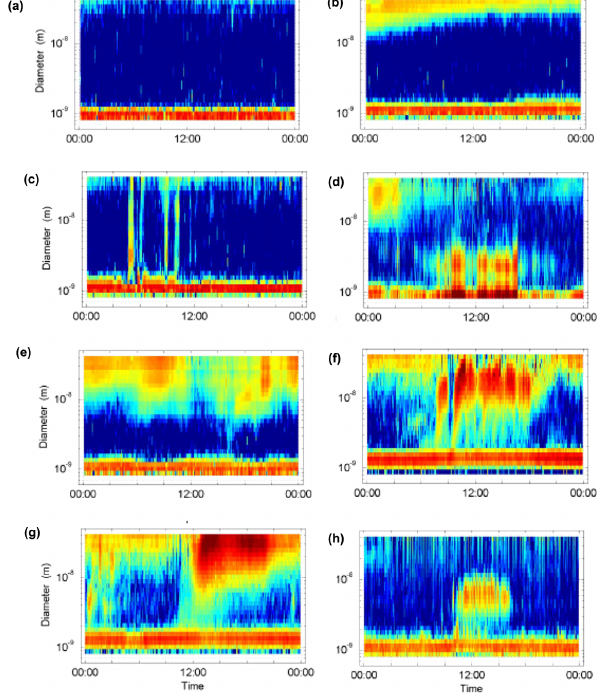
Figure 20. Typical negative ion number size distribution measured with the ion spectrometer in different environments and conditions: (a) no nucleation mode particles, just cluster ions observed in Fi- nokalia on 17 October 2008; (b) lower edge of Aitken mode par- ticles and cluster ions observed in Finokalia on 25 October 2008; (c) intermediate ion bursts observed during heavy rain in Finokalia on 28 December 2008; (d) intermediate ions observed during snow storm in Jungfraujoch on 28 November 2008; (e) undefined parti- cle formation in Cabauw on 15 September 2008; (f) changes in air mass and particle formation in Melpitz on 3 August 2008; (g) re- gional particle formation in Melpitz on 13 April 2009; and (h) local new particle formation plume in Mace Head on 16 October